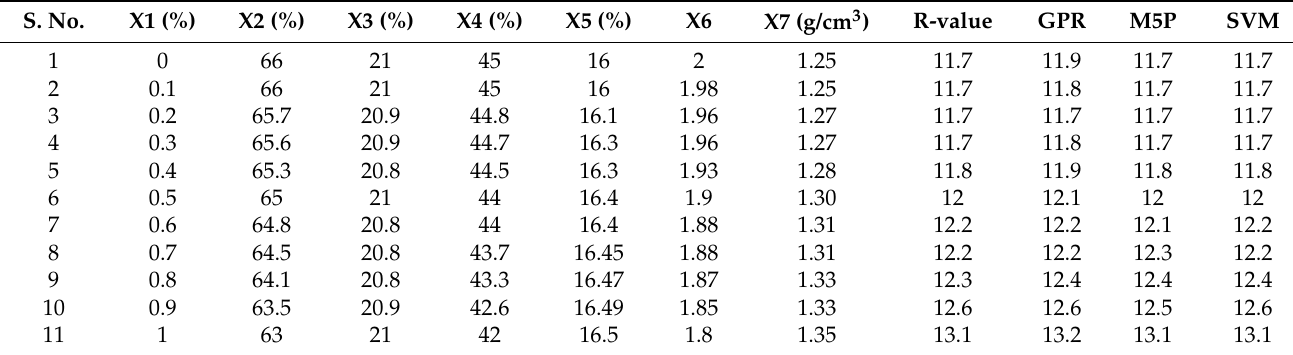
Table A1. Data for prediction modeling of